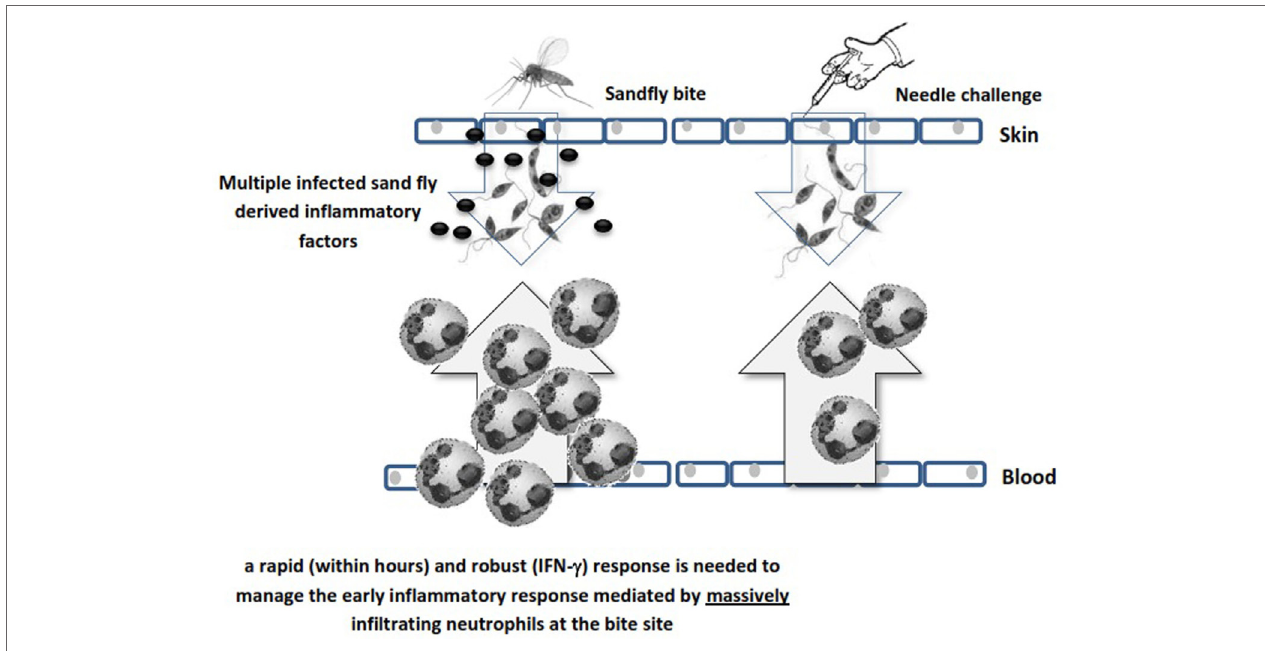
FiGURe 1 | Schematic illustration of the difference between sandfly’s bite and needle challenge in neutrophil recruitment. Different sandfly and parasite mediators massively recruit neutrophils to the bite site while needle challenge is less reactive in this respect due to lack of saliva